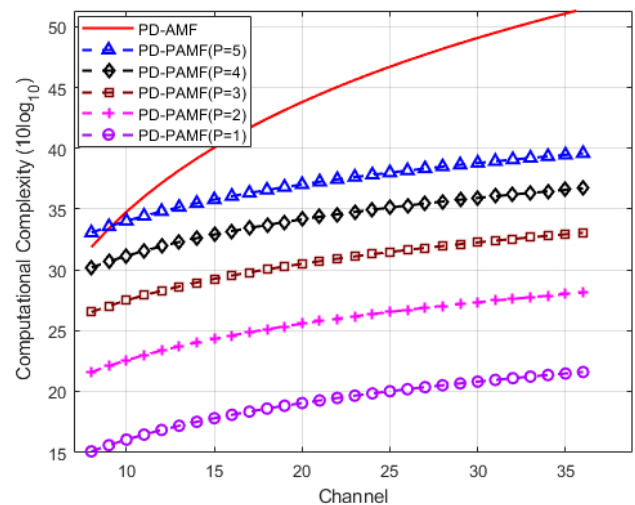
Figure 6. Computational complexity versus channels, K = 2 N, AR(1), AR(2), AR(3), AR(4),